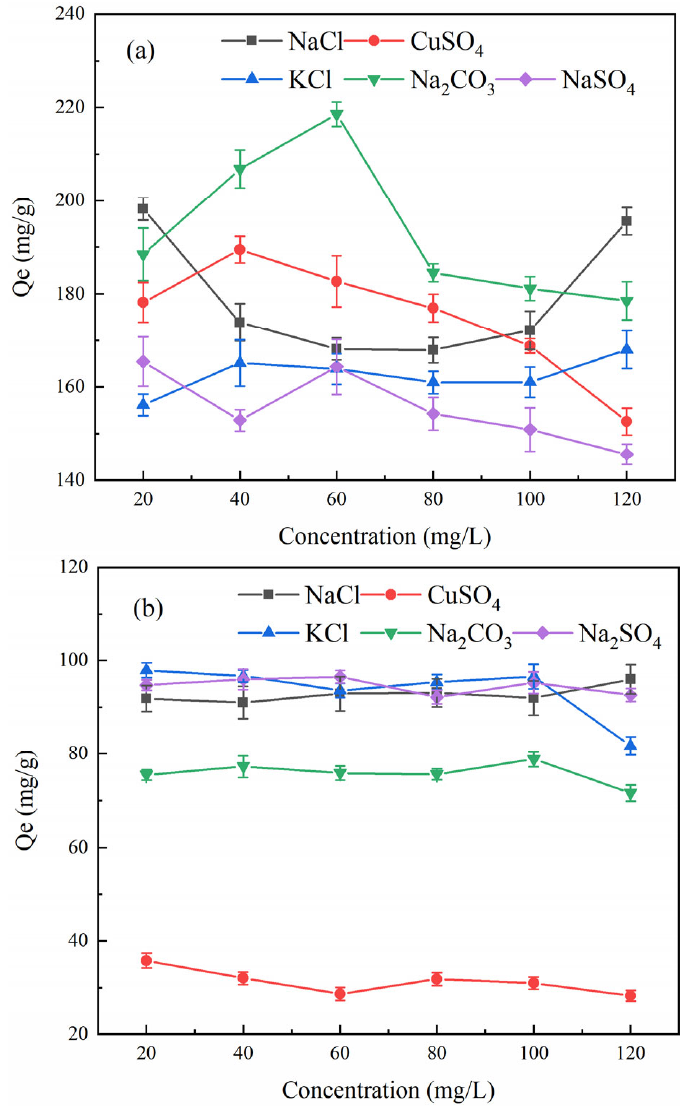
Figure 9. Variation of adsorption of ( a ) MB and ( b ) OFL by SAC with coexisting ion concentration.